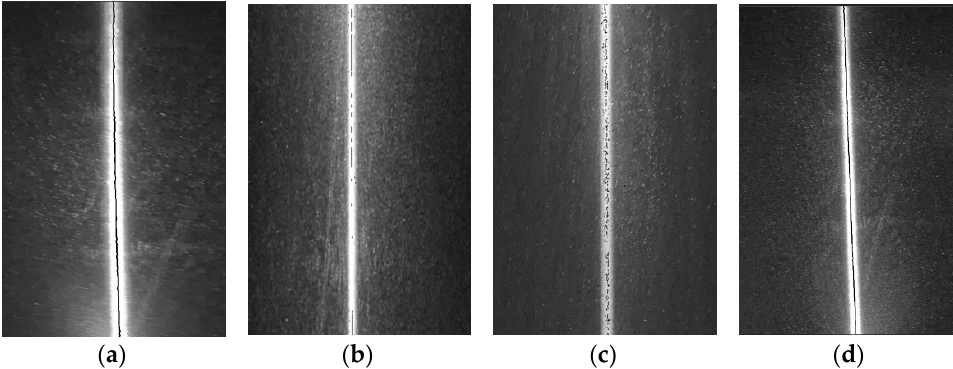
Figure 7. Results image of light stripe center extraction. ( a ) Proposed method. ( b ) Skeleton method. ( c ) Gray centroid method. ( d ) Standard method. Table 1. Comparison between different methods and the standard method for extracting light stripe center (unit: pixel).